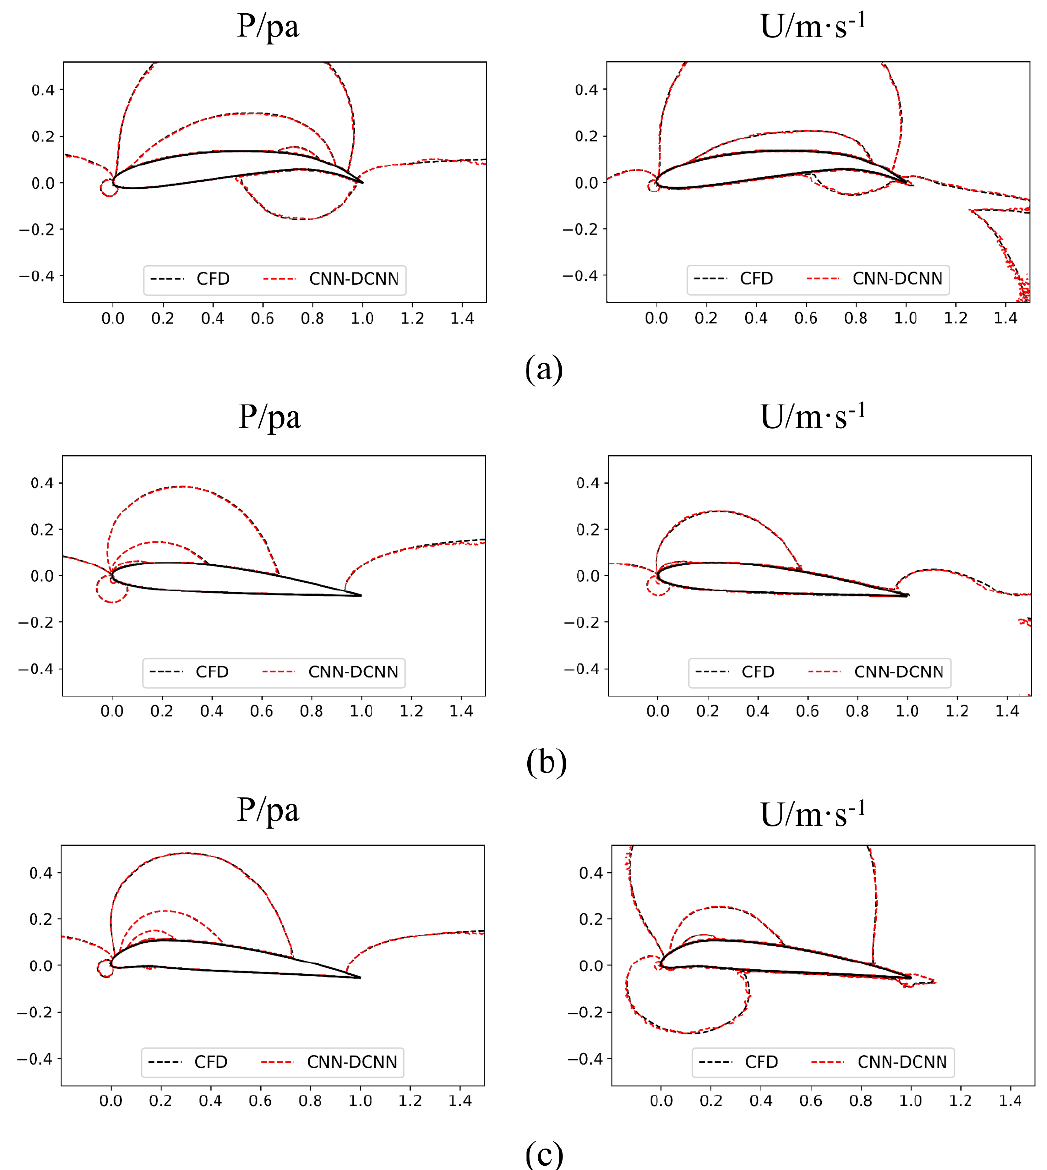
Figure 17. Comparison of the pressure and velocity contours for three cases: ( a ) case 4: NACA9712, AOA = 0°, Re = 2.5 × 10 6 ; ( b ) case 5: NACA2412, AOA = 5°, Re = 6 × 10 6 ; ( c ) case 6: NACA6212, AOA = 3°, Re = 8 × 10 6 .